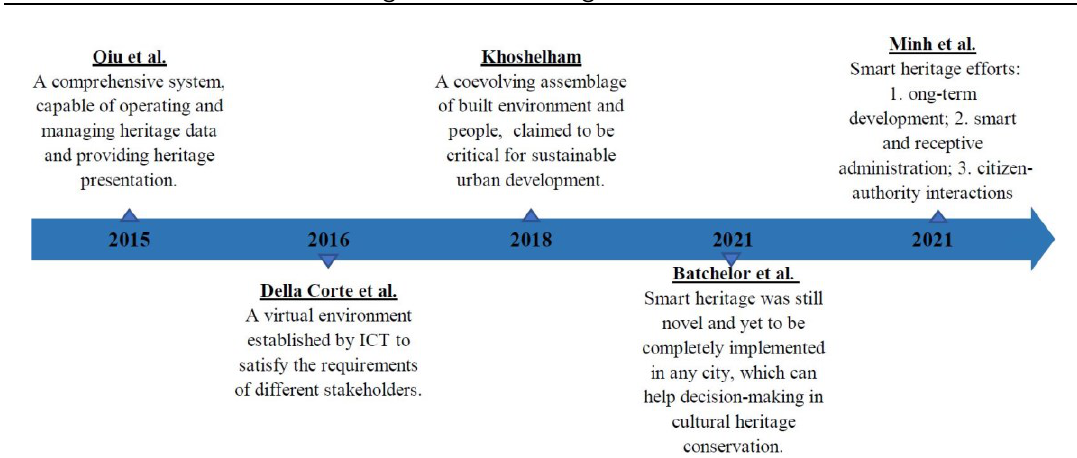
Figure 3. Timeline of Milestones in Defining and Developing Smart